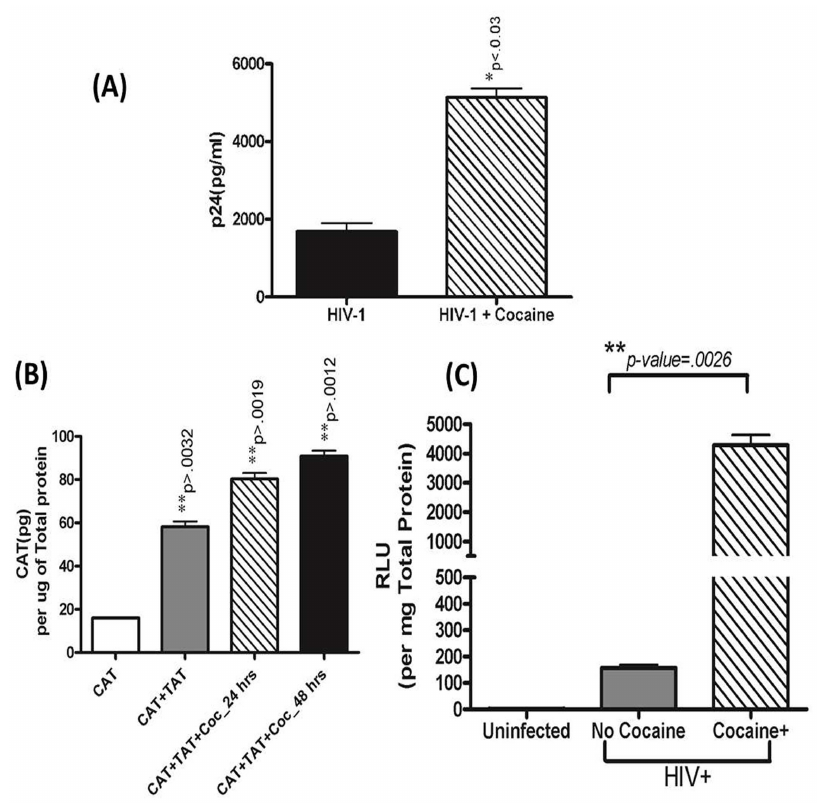
Figure 2. HIV replication increased in MDDCs treated with cocaine. (A) MDDCs (1 6 10 6 cells/ml) from normal donors were infected with HIV- 1 BAL at a concentration of 20 ng for 2 hr, followed by treatment 6 cocaine (1 m M) for 7 days. The culture supernatants were quantitated for p24 Ag. Significance is calculated with respect to HIV-1 treated control cells. ( B ) Effect of cocaine on HIV-1 transcription was determined using an LTR-CAT reporter data normalized to total protein concentration. ( C ) HIV-1 transcription was determined in MDDCs from normal donors infected with HIV- luciferase viruses competent for a single round of infection ( , 20 ng per (1 6 10 6 cells) in the presence/absence of cocaine (1 m M) for 72 hours. Cultures were harvested 72 hours post infection and luciferase assayed. Results shown are representative of mean 6 SEM of three experiments. p-value # 0.05 were considered to be significant.